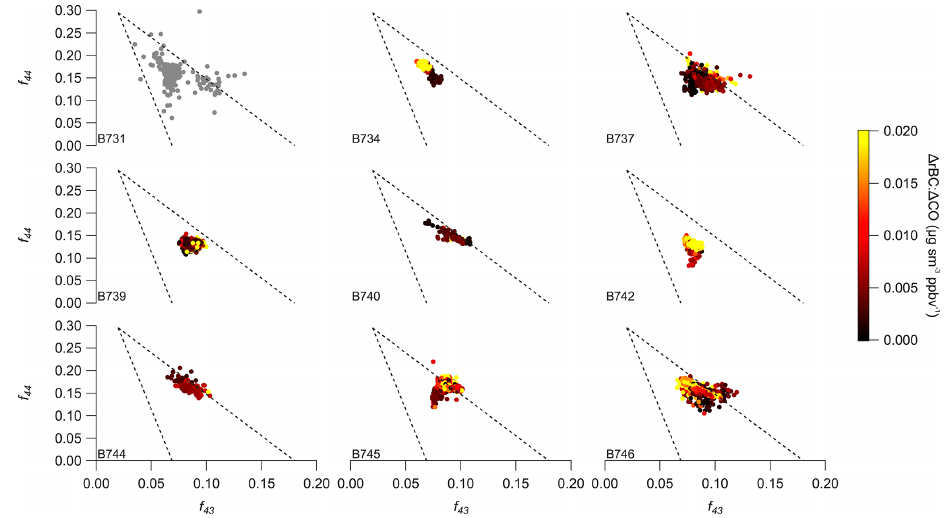
Figure 10. Comparison of f 44 vs. f 43 from the regional analysis across individual flights, where f x refers to the fraction of the organic aerosol mass signal at a given mass-to-charge ratio measured by the aerosol mass spectrometer. Points are coloured according to the ratio of refractory black carbon (rBC) to carbon monoxide (CO) except for B731 where limited rBC data were available. Dashed lines show the triangle space reported by prior studies focussed on organic aerosol less influenced by biomass burning (Morgan et al., 2010; Ng et al.,